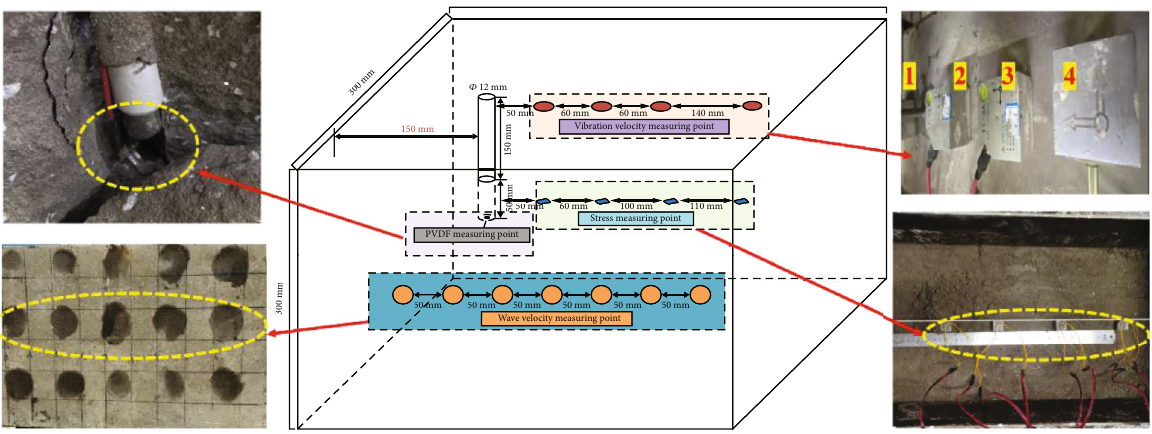
Figure 2: The layout of measuring